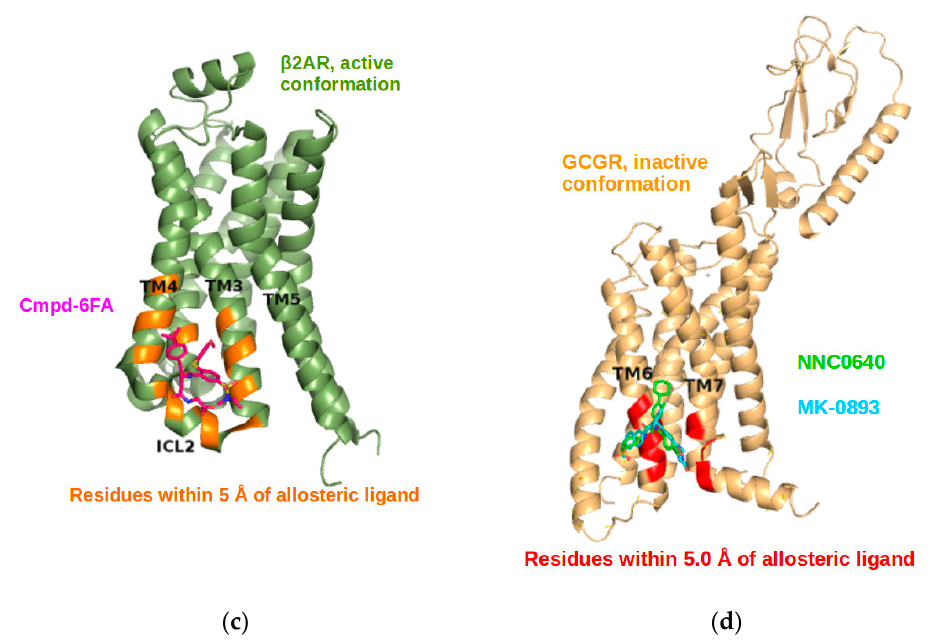
Figure 1. Experimental structures of β 2AR and glucagon receptor (GCGR) in the presence of allosteric modulators. β 2AR in the inactive conformation (pink) bound to ( a ) Cmpd-15PA (PDB: 5X7D); ( b ) AS408 (PDB: 6OBA; ( c ) β 2AR in the active conformation (green), bound to Cmpd-6FA (PDB: 6N48); ( d ) GCGR in the inactive conformation, in the presence of the allosteric ligands NNC0640 and MK-0893 (green and cyan; PDB codes 5XEZ and 5EE7, respectively). Ligands are shown as sticks and residues within 5.0 Å of a ligand are highlighted in different colors.